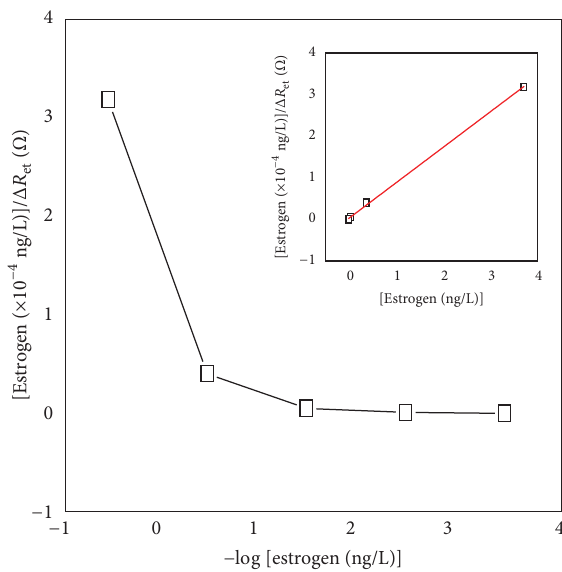
Figure 2: Plot of [17 𝛽 -estradiol]/ Δ𝑅 et versus − log [17𝛽 -estradiol ] in 3.7 × 10 −4 ng/L to 3.7 ng/L 17 𝛽 -estradiol. Inset: plot of [17 𝛽 - estradiol]/ Δ𝑅 et versus [17 𝛽 -estradiol] in 3.7 × 10 −4 ng/L to 3.7 ng/L 17 𝛽 -estradiol. Values represent the mean ± standard deviation from three separate experiments. The experiments were repeated by 3 times.